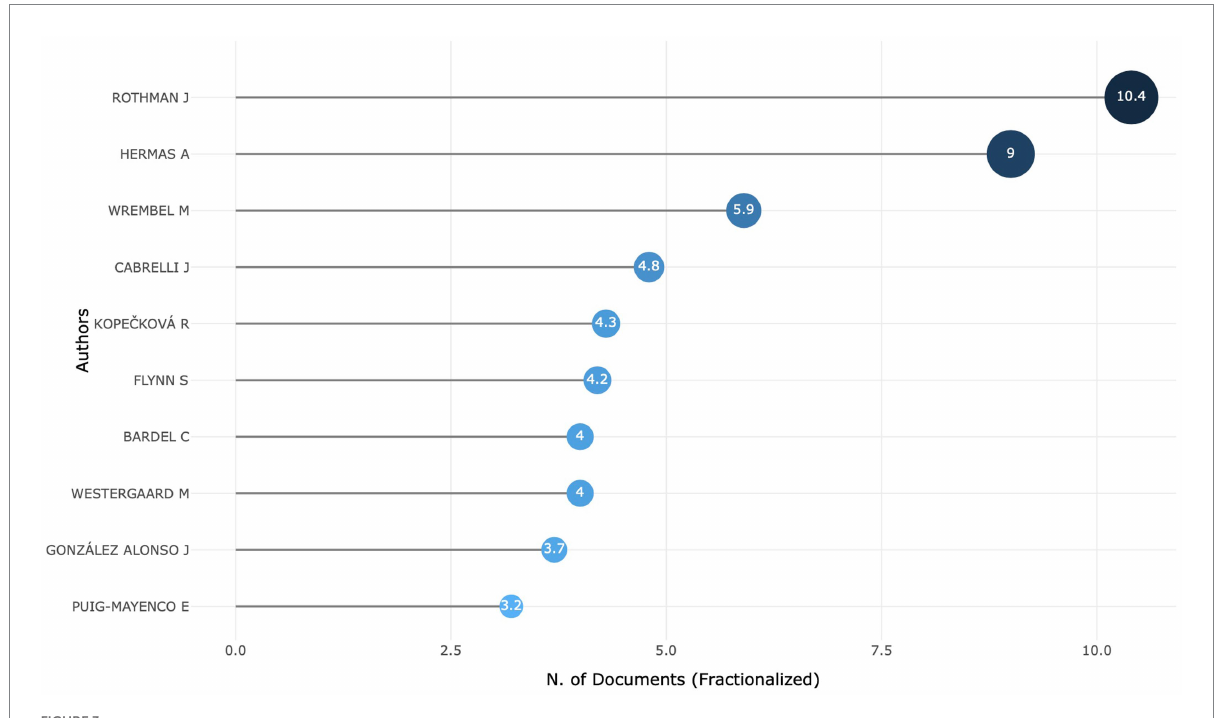
FIGURE 3 Top 10 ranking authors with the highest number of